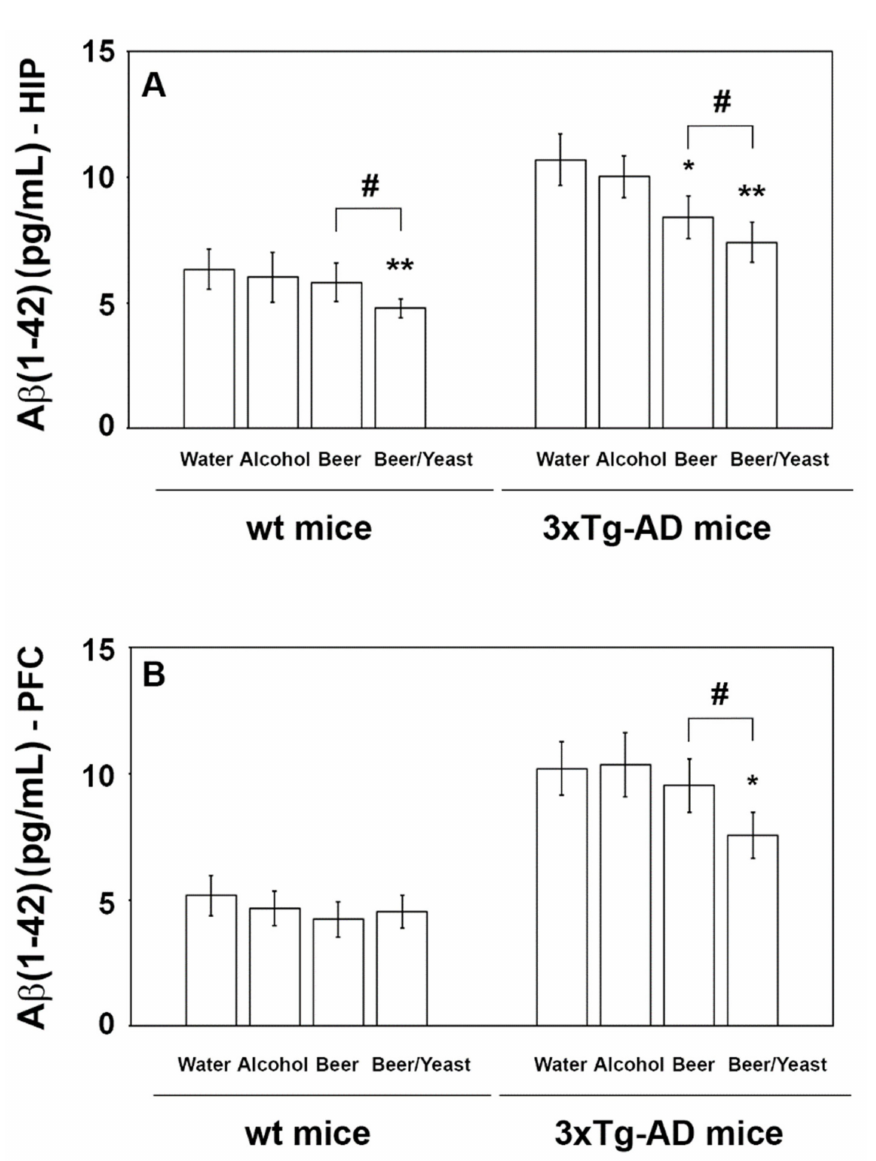
Figure 3. Levels of the A β (1-42) peptide measured by ELISA on brain homogenates of the wt and 3xTg-AD mice treated with water, alcohol, beer and beer/yeast. In wt mice, A β (1-42) was decreased in the HIP of mice treated with beer/yeast ( A ), but it did not change in the PFC ( B ). Beer and beer/yeast decreased the level of A β (1-42) in the HIP of 3xTg-AD mice ( A ). Beer/yeast decreased the level of A β (1-42) in the PFC of 3xTg-AD mice ( B ). Concentrations are expressed as pg/mL. (HIP: * p < 0.05, B vs. W and A; ** p < 0.01, B/Y vs. W and A; # p < 0.05, B/Y vs. B; PFC: * p < 0.05, B/Y vs. W and A; # p < 0.05, B/Y vs.